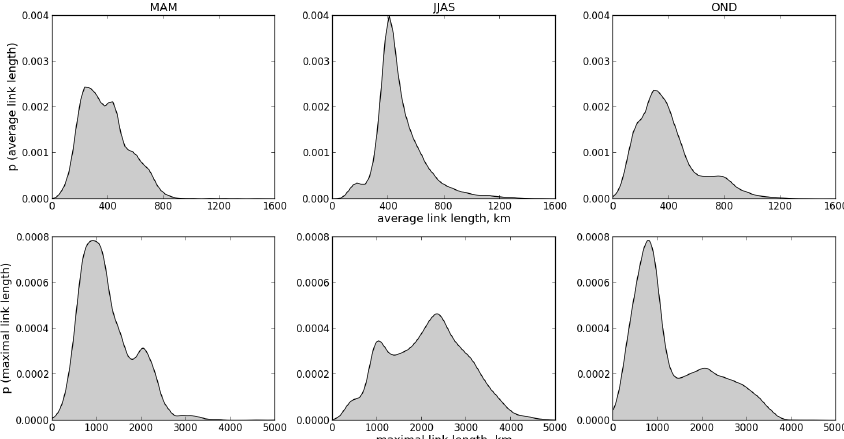
Figure 4. Average and maximal link length distributions for the three time periods based on the TRMM data: pre-monsoon (MAM), monsoon (JJAS), and post-monsoon